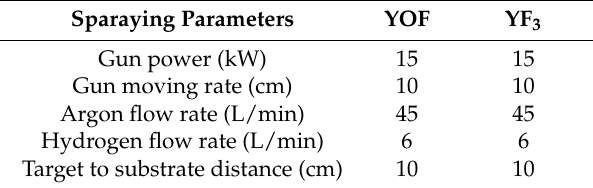
Table 1. Spraying parameters of the yttrium oxyfluoride (YOF) and yttrium fluoride (YF 3 )